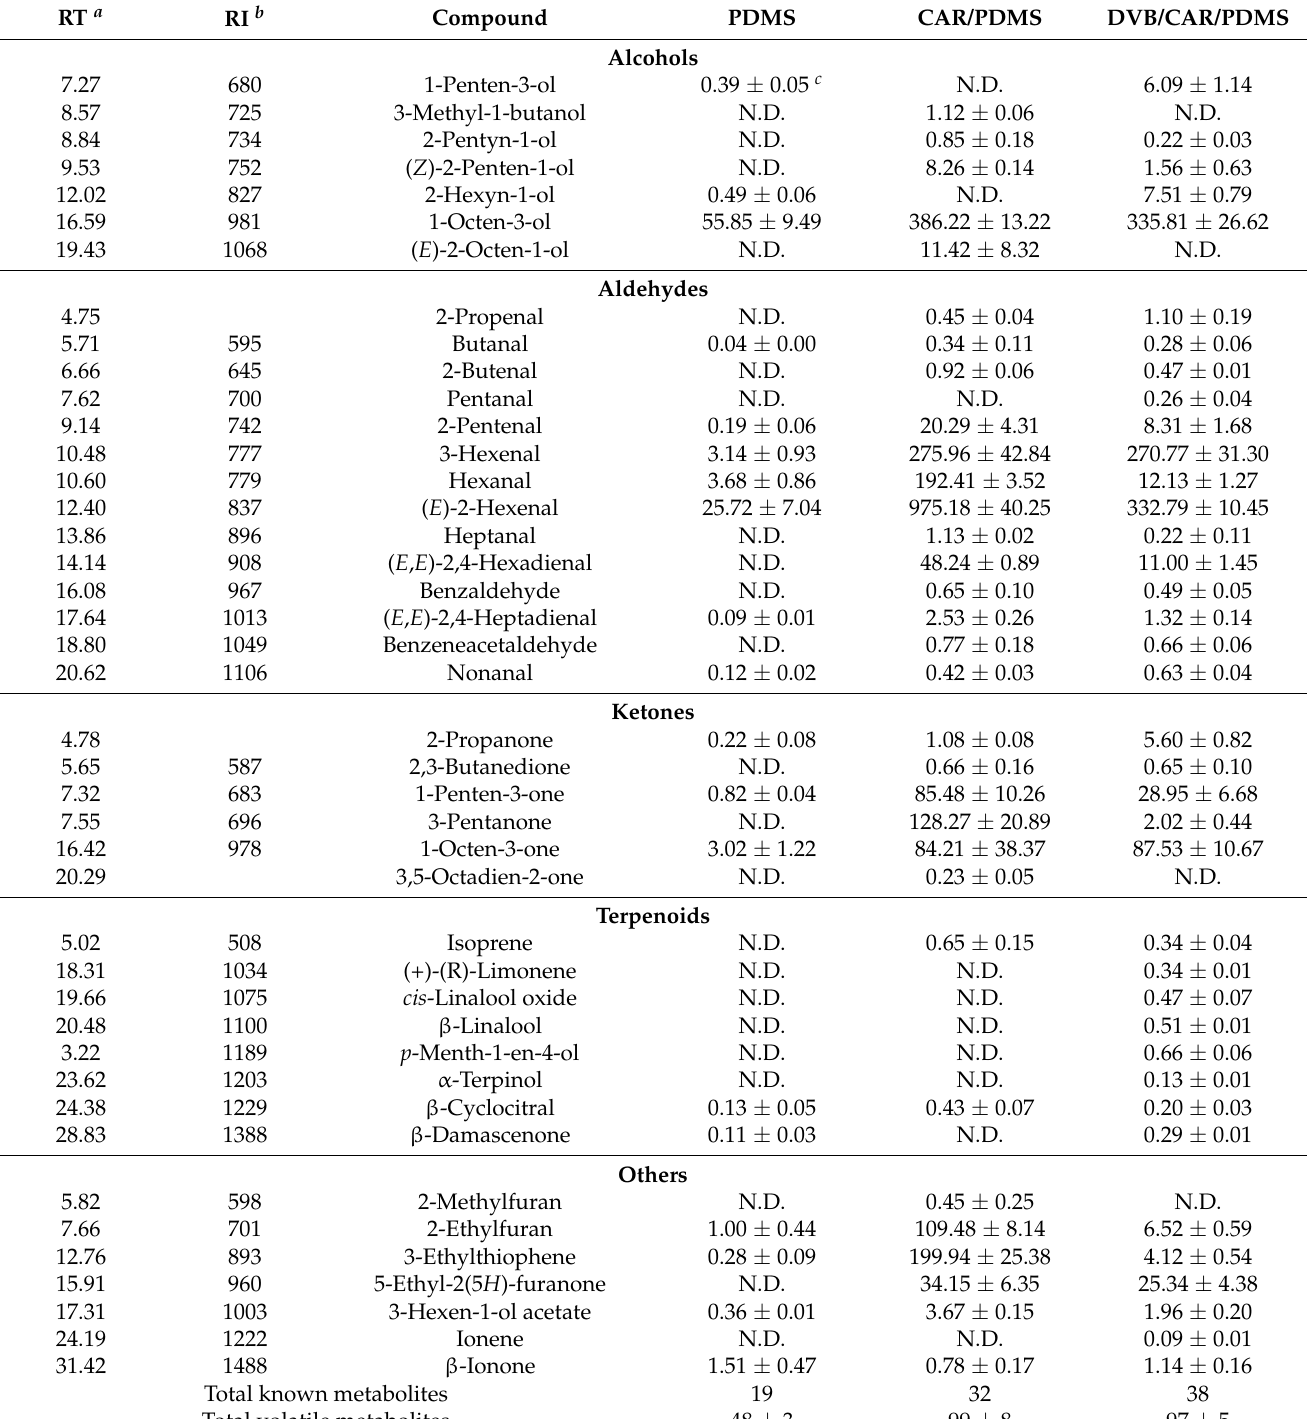
Table 1. Volatile metabolites detected in alfalfa leaves using different SPME fibers at 50 ◦ C for 20